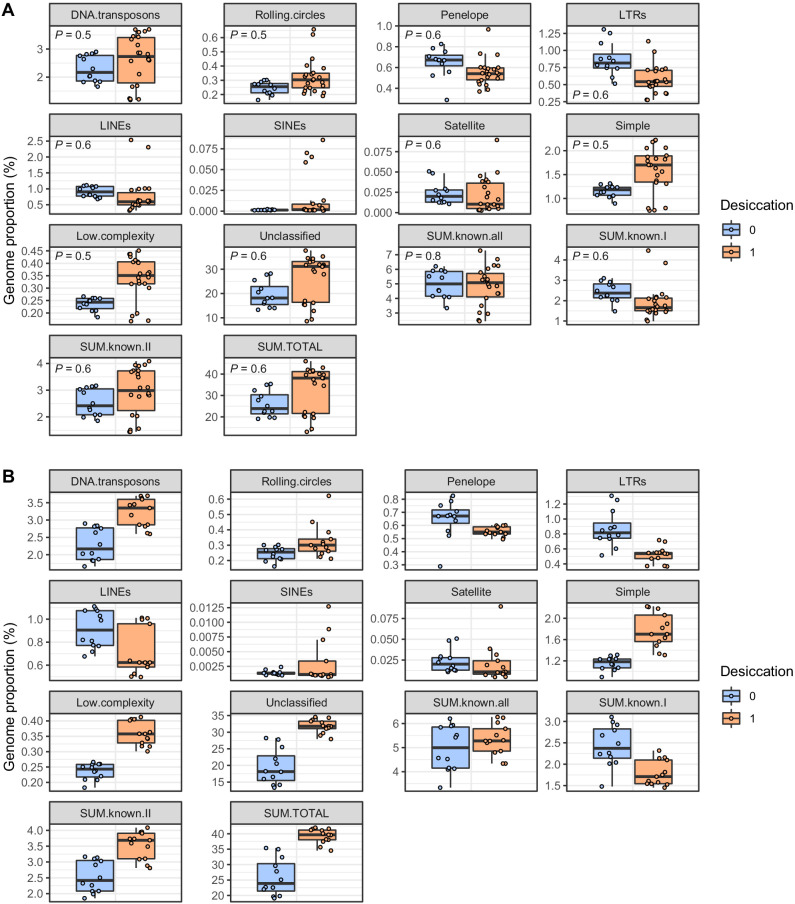
Boxplots showing the raw data for repeat content in desiccating versus nondesiccating bdelloids, shown for (A) all bdelloids and (B) Rotaria lineages only.Data is plotted as the proportion (%) of genome span accounted for each repeat type. FDR-adjusted p-values for phylogenetic linear models testing for significant differences between desiccating and nondesiccating species (accounting for phylogeny) are shown for each TE subclass in panel A (all nonsignificant). Desiccation tolerance indicated in blue (nondesiccating) and orange (desiccating). Boxplots show the median (band), interquartile range (box), and minimum/maximum values (whiskers). Underlying data are shown as jittered points. Summed categories defined as follows: ‘Known all’, all classified TEs (i.e. satellite, simple, low complexity, and unclassified excluded); ‘Known I’, class I retrotransposon families; ‘Known II’, class II DNA transposon families; ‘Total’, grand total of all repeats.